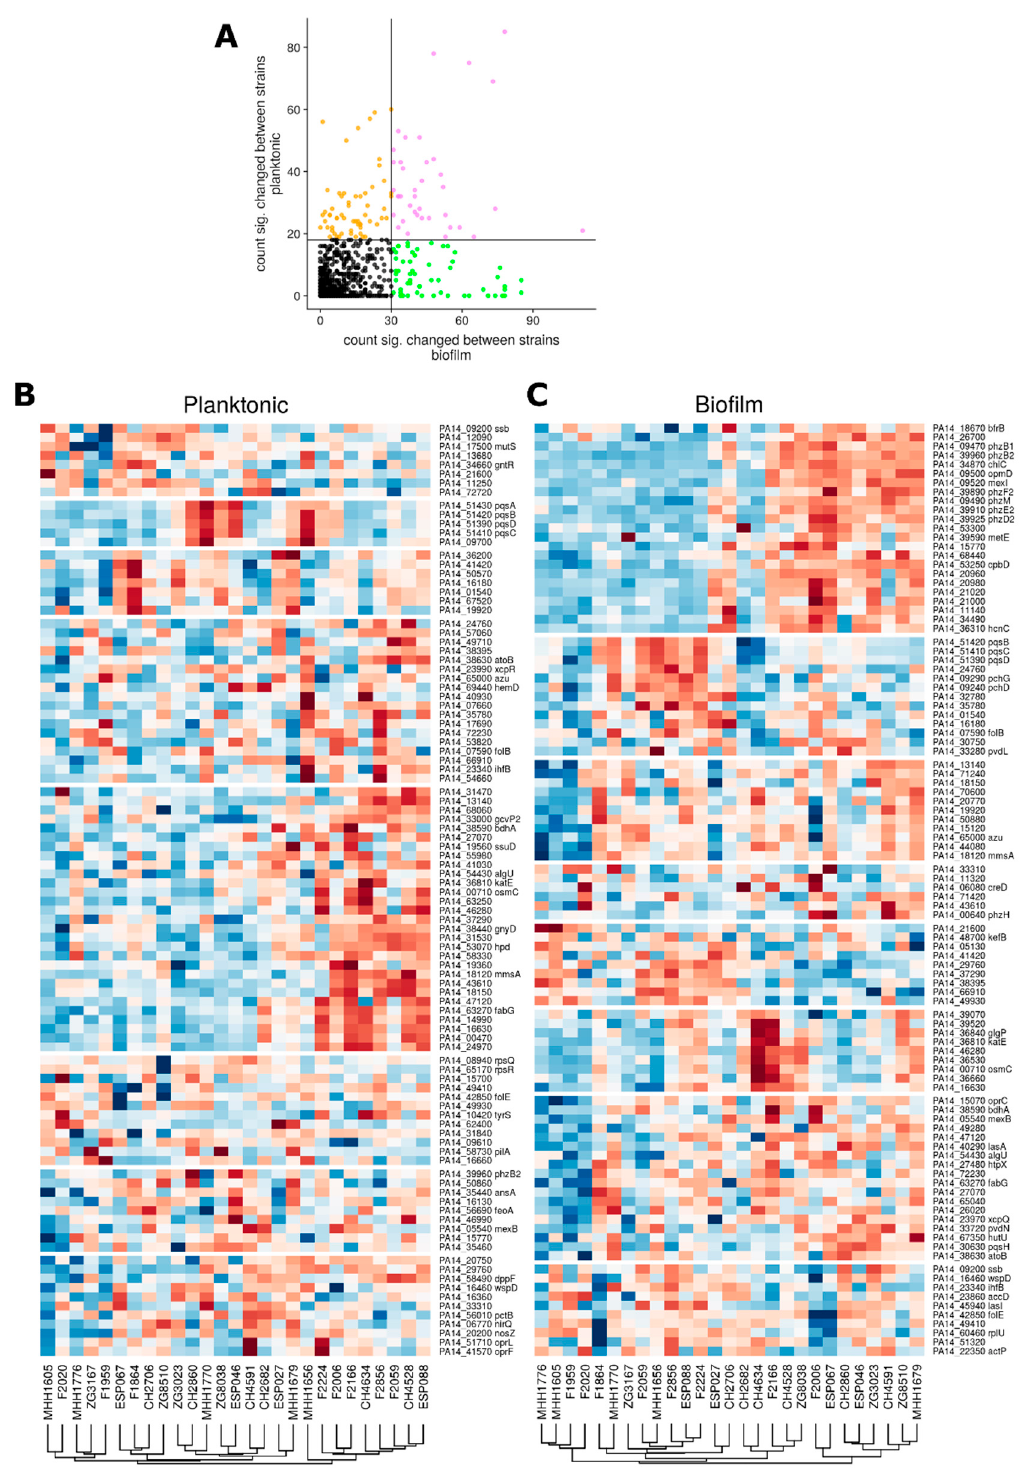
Figure A2. Variable protein expression between strains. ( A ) Comparison of variably expressed proteins under biofilm and planktonic condition. The count of significant differential expression between two strains is plotted for both conditions. The 10% most variable expressed proteins are shown in A and B. ( B ) Heatmap of 10% most variable proteins under planktonic condition.( C ) Heatmap of 10% most variable proteins under biofilm condition.